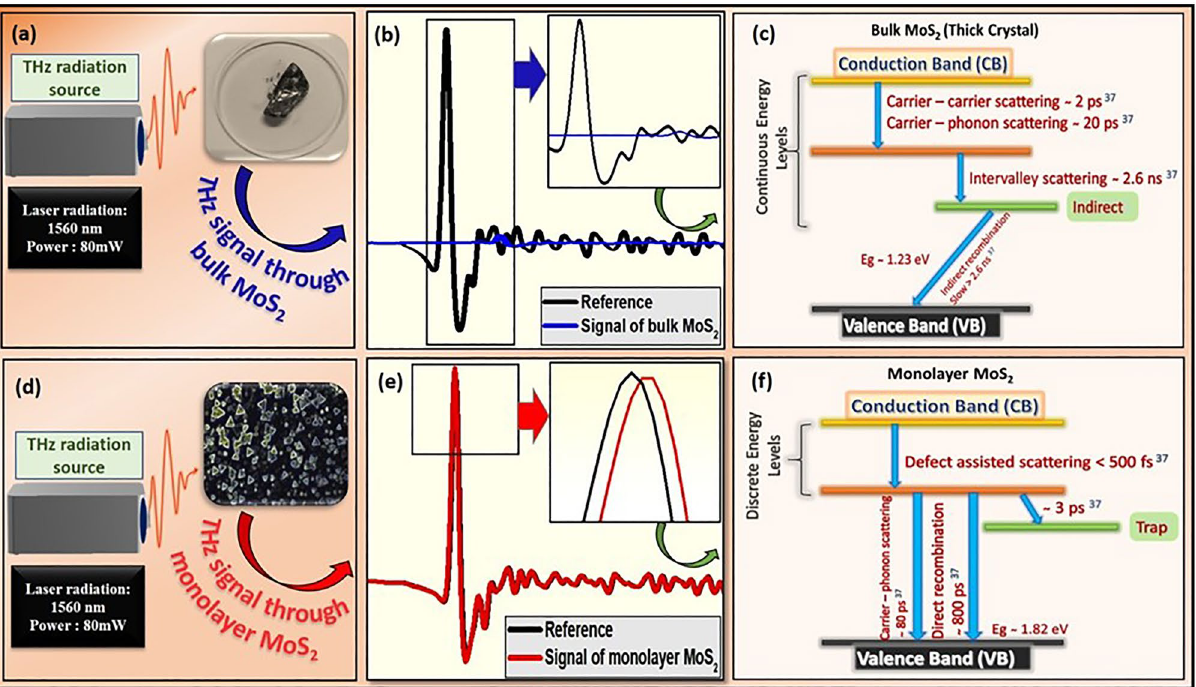
Figure 7. Comparative study of THz characteristics of bulk and monolayer MoS 2 . ( a ) THz signal incident on bulk MoS 2